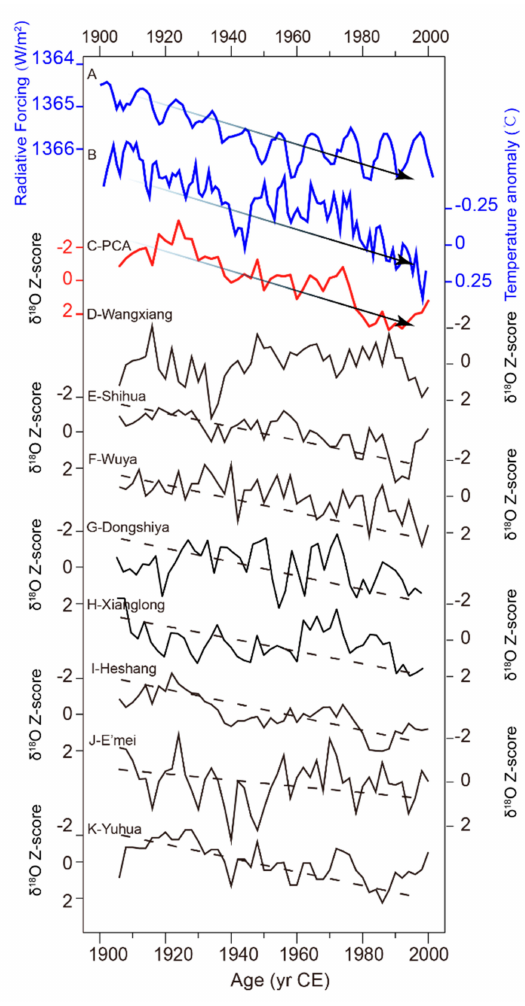
Figure 11. High-resolution speleothem δ 18 O records from China with the solar radiation and global temperature curves for the 20th century. ( A ) Solar radiation [242]; ( B ) Temperature anomaly (data from National Centers for Environmental Information); ( C ) First Principal Component of the speleothem δ 18 O records in ( D – K ); ( D ) Wanxiang Cave [10]; (E) Shihua Cave [128]; ( F ) Wuya Cave [150]; ( G ) Dongshiya Cave [50]; ( H ) Xianglong Cave [246]; ( I ) Heshang Cave [15]; ( J ) E’mei Cave [54] and ( K ) Yuhua Cave [178]. Speleothem records in ( D – K ) have resolutions higher than 2 years. Dotted lines in ( D – K ) show the long-term trend of each speleothem record. Principal Component Analysis has been done on speleothem δ 18 O converted to standard Z-scores using the software Origin Pro 2016. All axes are